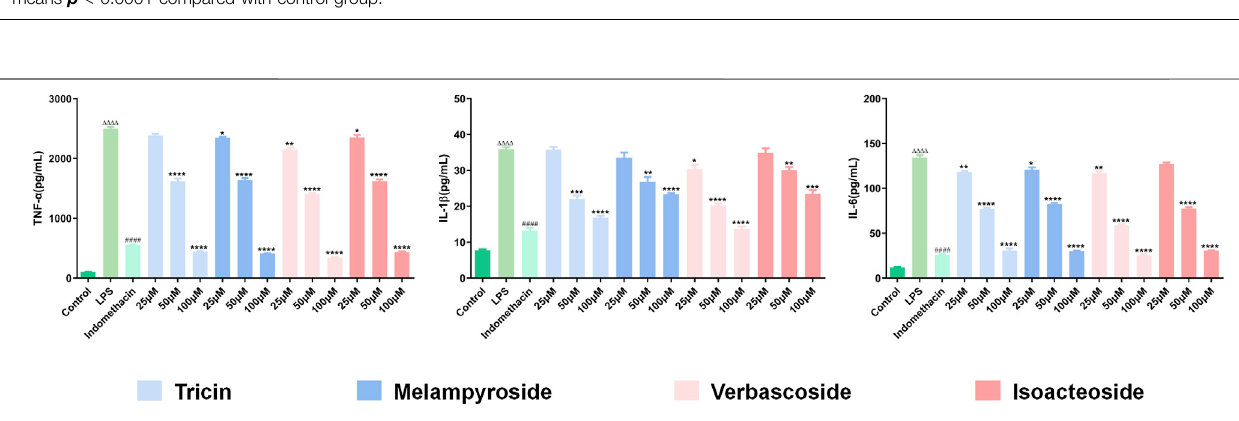
FIGURE 11 | Effects of Different target compounds from O. vulgaris on TNF- α , IL-1 β and IL-6 Content in RAW 264.7 Cells Induced by LPS. Data are presented as means ± SD,n (cid:2) 5.*means p < 0.05,** means p < 0.01,***means p < 0.001,****means p < 0.0001comparedwithLPSgroup. #### means p < 0.0001compared with LPS group. △△△△ means p < 0.0001 compared with control